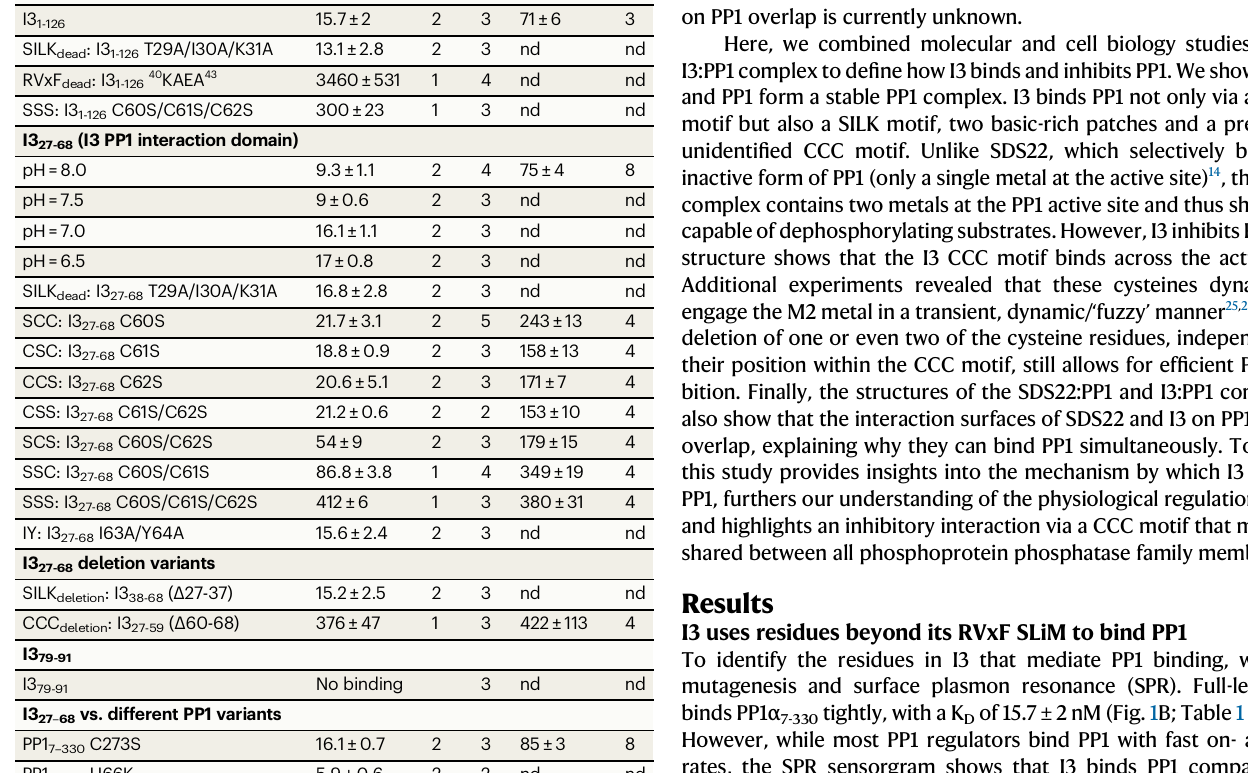
Table 1 | I3:PP1 binding and inhibition PP1 and I3 variants Binding Inhibition PP1 7-330 vs I3 variants